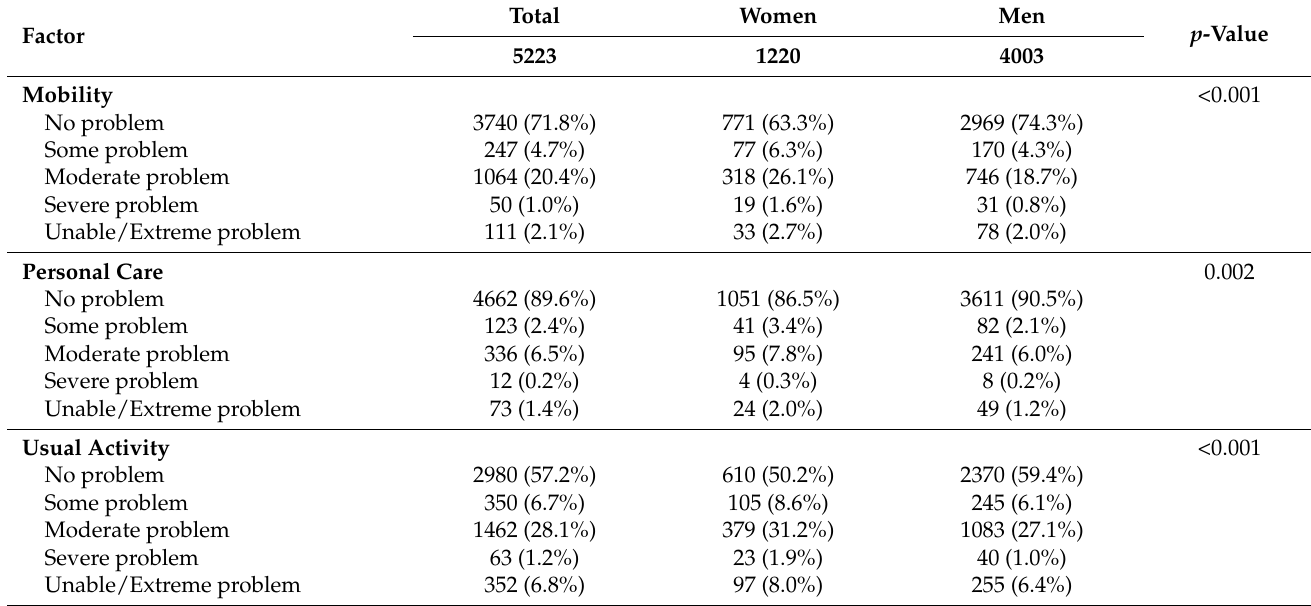
Table 2. Assessing QoL and VAS for difference between men and